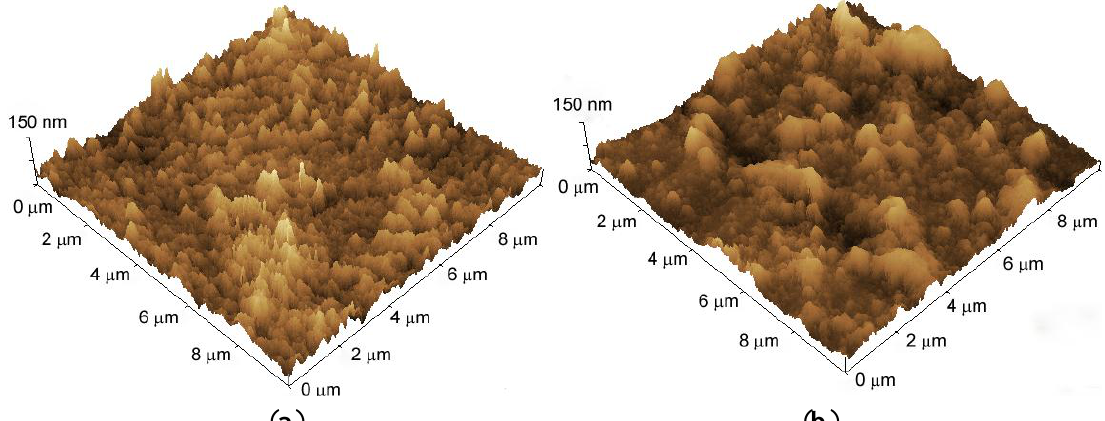
Figure 3. AFM three-dimensional images of ( a ) PEI(PAA/CHI) films. The films were prepared using pH 7.0 PAA and PVS solutions and pH 5.0 CHI